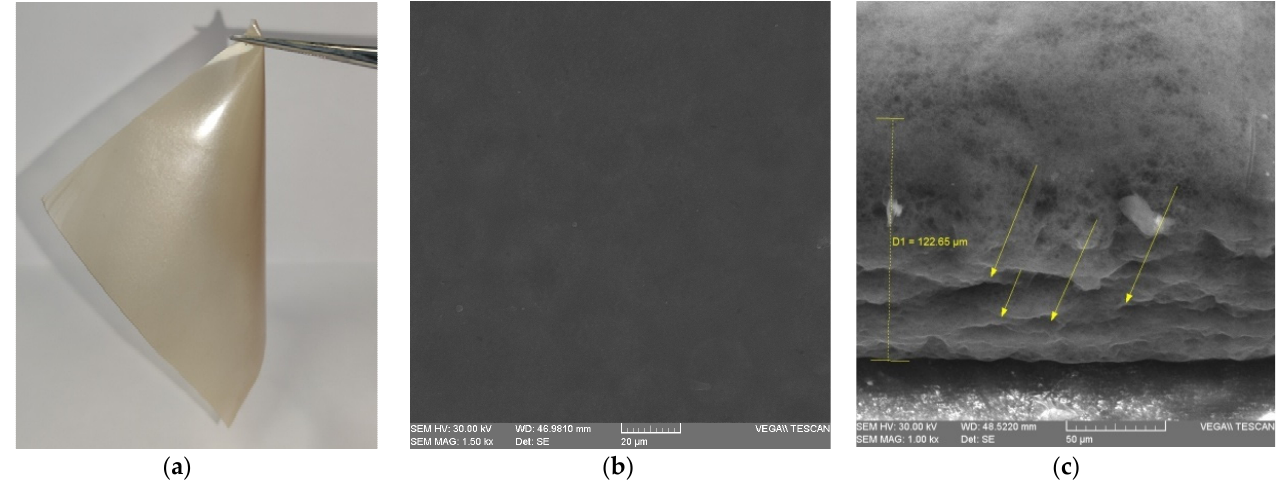
Figure 9. Optimal film and SEM micrographs. ( a ) Film made of 1 g β –glucan, 0.6 g SA, 14 mL PJ and 0.83 g glycerin; ( b ) Upper view SEM micrographs (1.5 kx); ( c ) Cross section micrographs of the film (1 kx).